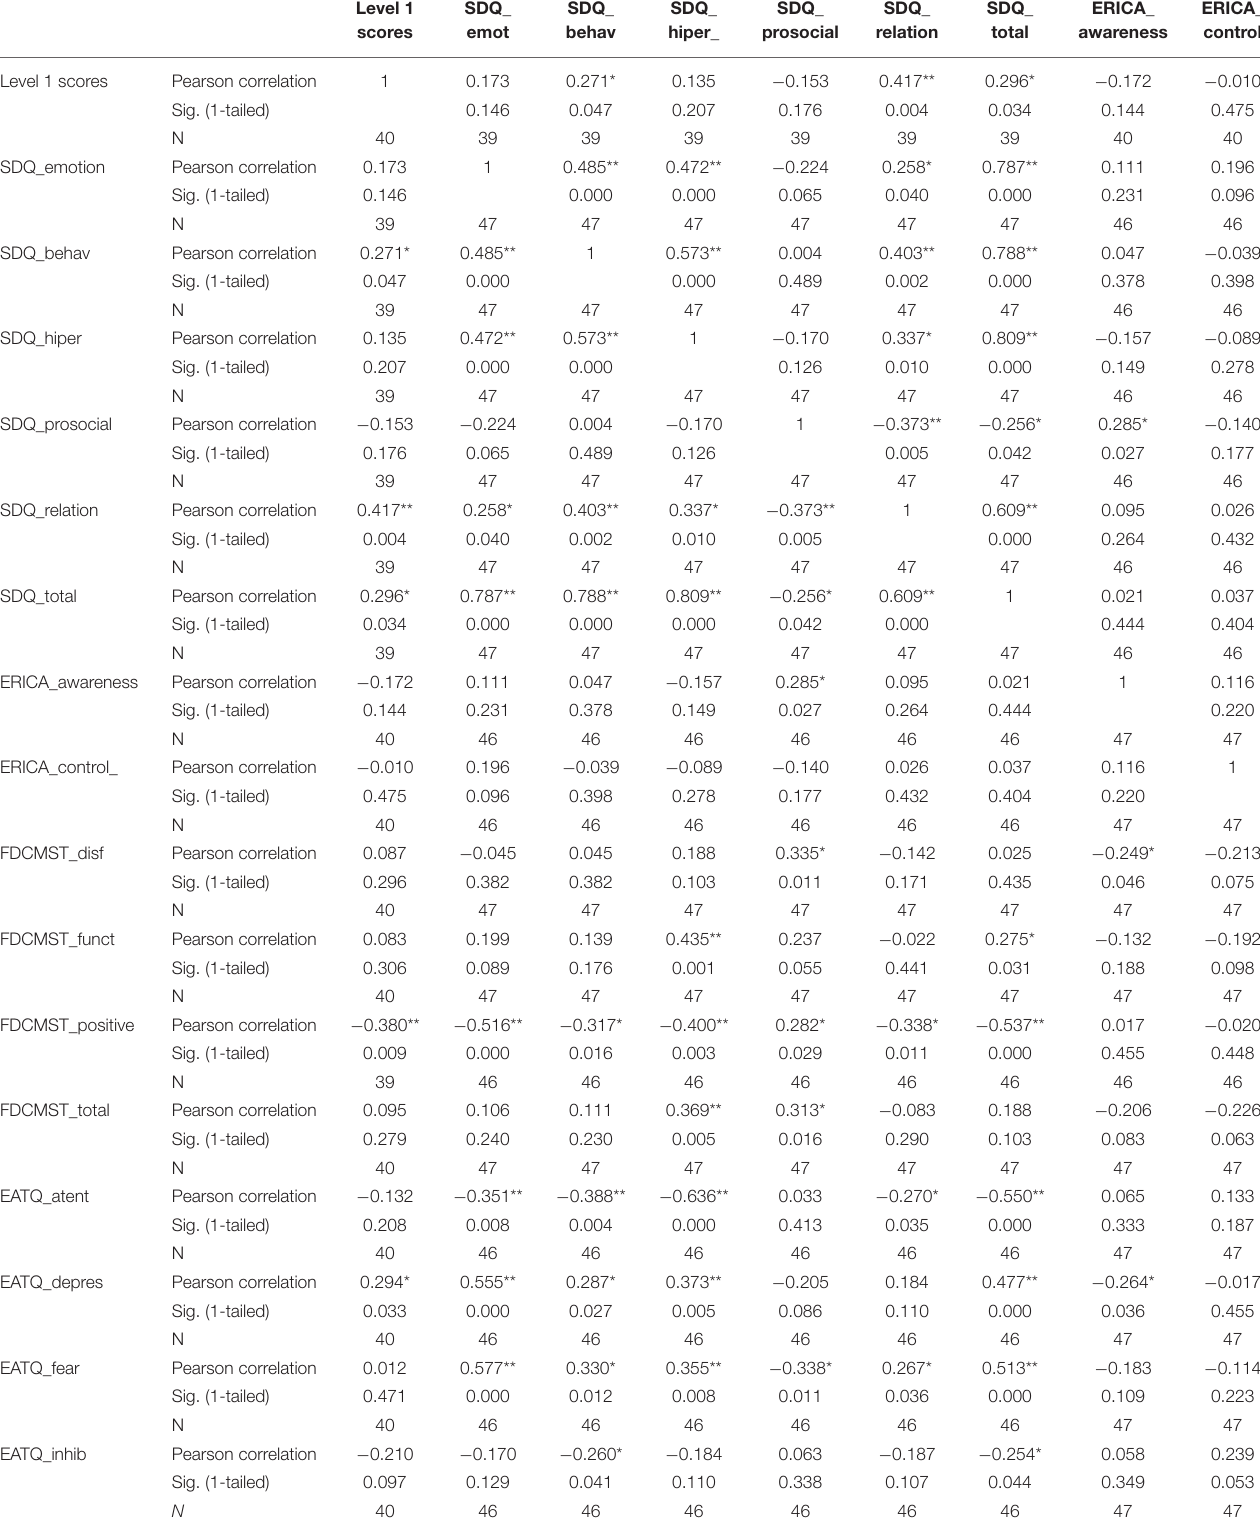
TABLE 3A | Correlation analysis for Level 1